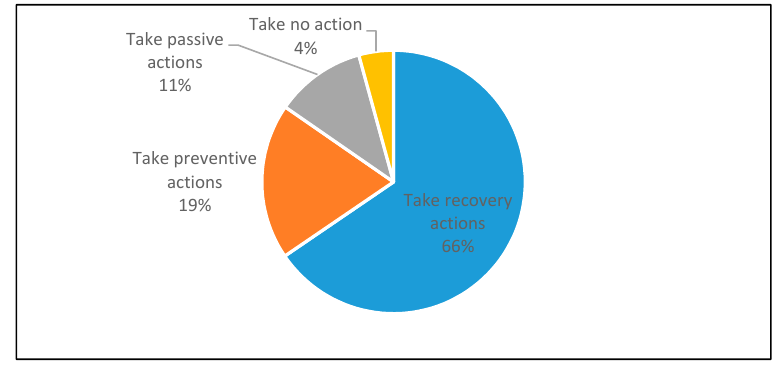
Figure 3. Types of flood protection measures taken by respondents.